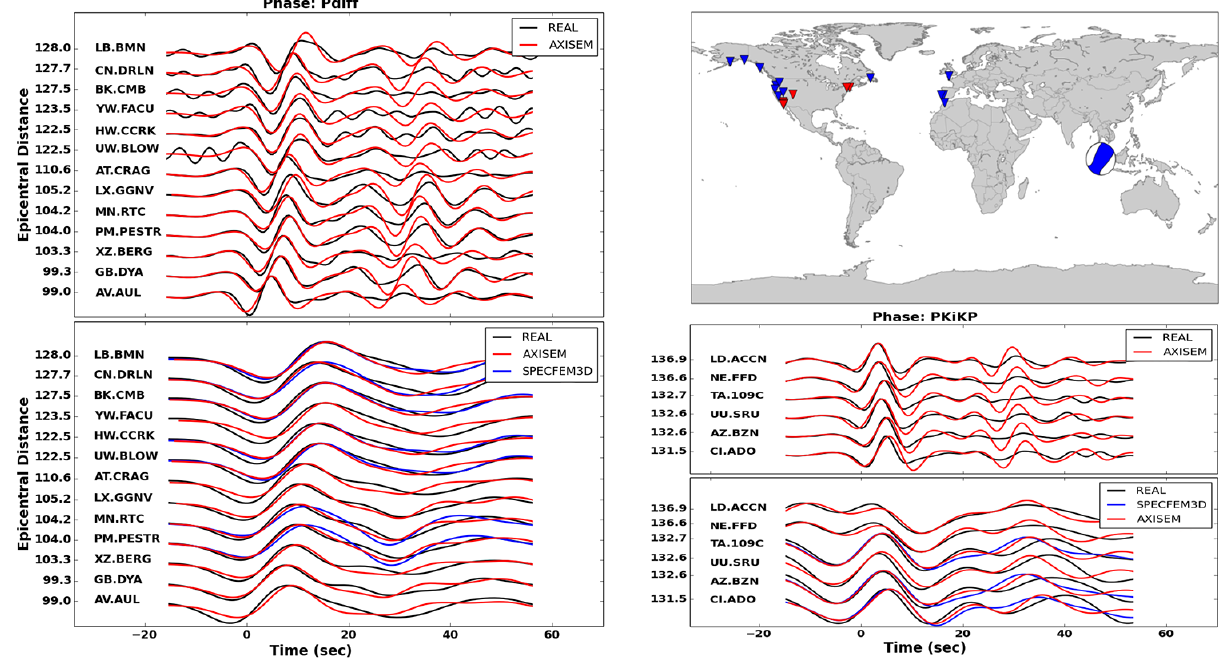
Figure 16. A comparison of AxiSEM synthetics with recorded data and SPECFEM synthetics (Tromp et al., 2010) for an Mw7.5 2009 event in southern Sumatra at 82km depth. Top right: Event-station distribution, where red triangles are for core-phase PKiKP, blue for the Pdiff CMB-diffracted phase. Left: Pdiff synthetics and observed data filtered at 5–15s (top) and 15–45s (bottom). In the latter case, SPECFEM synthetics are included, which are accurate down to 17s. Bottom right: The same for PKiKIP. AxiSEM synthetics are simulated through a viscoelastic, anisotropic PREM model, SPECFEM synthetics through the S362ANI tomographic model (Kustowski et al., 2008), and both sets are shifted by cross-correlation traveltimes to align with the respective phases (left: Pdiff, right: PKiKP). Traveltime shifts are about 2–6s (see main